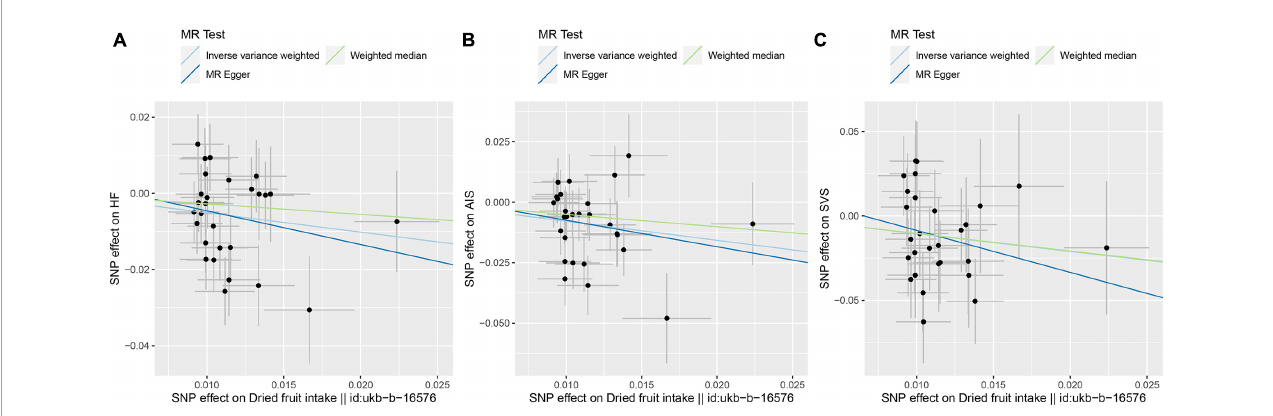
FIGURE3 Scatter plot of Mendelian randomization (MR) results. (A) Scatter plot of genetic correlations of dried fruit intake and heart failure (HF) using different MR methods. (B) Scatter plot of genetic correlations of dried fruit intake and any ischemic stroke (AIS) using different MR methods. (C) Scatter plot of genetic correlations of dried fruit intake and small vessel stroke (SVS) using different MR